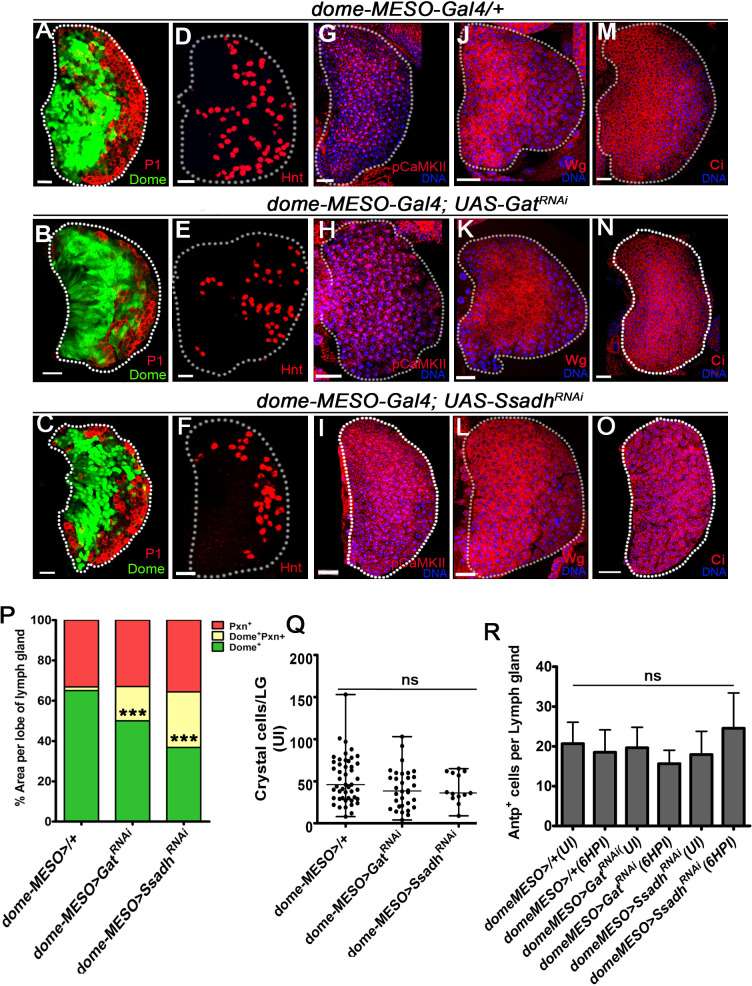
GABA-shunt pathway is dispensable for normal hematopoiesis.DNA is stained with DAPI (blue). Representative 3rd instar lymph gland images showing progenitors in green (Domeless, Dome), plasmatocytes in red (P1) and crystal cells (red, Hindsight, Hnt). Scale bar in panels A-O = 20 µm. For lymph glands ‘n’ represents lymph gland lobes analyzed. ns is nonsignificant. For better representation of the lymph gland primary lobes, the images shown, have been edited for removal of adjacent tissues (like dorsal vessel and ring gland). (A–F) Lymph gland development and hematopoiesis in progenitor-specific loss of Gat and Ssadh function. Compared to (A, D) Control (dome-MESO-Gal4, UAS-GFP/+), expressing (B, E) GatRNAi in progenitor cells (dome-MESO-Gal4, UAS-GFP; UAS-GatRNAi) and (C, F) SsadhRNAi in progenitor cells (dome-MESO-Gal4, UAS-GFP; UAS-SsadhRNAi), expression of (A–C) P1 (red, marking plasmatocytes) and (D–F) Hnt (red, marking crystal cells) in lymph glands remains unaffected. Also see quantifications in (Q). (G–O) Expression analysis of (G–I) pCaMKII, (J–L) wingless (Wg), and (M–O) cubitus interruptus (Ci) in (G, J, M) control (dome-MESO-Gal4, UAS-GFP/+), (H, K, N) GatRNAi (dome-MESO-Gal4, UAS-GFP; UAS-GatRNAi) and (I, L, O) SsadhRNAi (dome-MESO-Gal4, UAS-GFP; UAS-SsadhRNAi) show no changes in their pattern or levels. (P) Graphical representation of percentage areas of progenitor cells (green, Dome+ only), intermediate population (IP, yellow, Dome+ Pxn+) and differentiating blood cells (red, Peroxidasin+ only). An expansion of IP is noted in genetic knock-downs of Gat and Ssadh, dome-MESO-Gal4, UAS-GFP; UAS-GatRNAi (n = 7, ***p<0.0001) and dome-MESO-Gal4, UAS-GFP; UAS-SsadhRNAi (n = 11, ***p<0.0001) in comparison to dome-MESO-Gal4, UAS-GFP/+ (control, n = 8). For details refer Supplementary file 3. (Q) Quantification of total crystal cells (Hindsight+) in lymph gland control (dome-MESO-Gal4, UAS-GFP/+, n = 47), GatRNAi (dome-MESO-Gal4, UAS-GFP; UAS-Gat RNAi, n = 32, ns) and SsadhRNAi (dome-MESO-Gal4, UAS-GFP; UAS-Ssadh RNAi, n = 13, ns). For details refer Supplementary file 5. (R) Quantification of Antp + cells per lymph gland in control in uninfected state (dome-MESO-Gal4, UAS-GFP/+, n = 17) and at 6HPI (dome-MESO-Gal4, UAS-GFP/+, n = 20, ns), expressing GatRNAi in progenitors cells in uninfected state (dome-MESO-Gal4, UAS-GFP; UAS-Gat RNAi, n = 11, ns compared to dome-MESO-Gal4, UAS-GFP/+, uninfected) and at 6HPI (dome-MESO-Gal4, UAS-GFP; UAS-Gat RNAi, n = 8, ns compared to dome-MESO-Gal4, UAS-GFP/+, 6HPI), expressing SsadhRNAi in progenitors cells in uninfected state (dome-MESO-Gal4, UAS-GFP; UAS-Ssadh RNAi, n = 15, ns compared to dome-MESO-Gal4, UAS-GFP/+, uninfected) and at 6HPI (dome-MESO-Gal4, UAS-GFP; UAS-Ssadh RNAi, n = 21, ns compared to dome-MESO-Gal4, UAS-GFP/+, 6HPI).Figure 2—figure supplement 3—source data 1.Contains numerical data plotted in Figure 2—figure supplement 3P,Q and R.